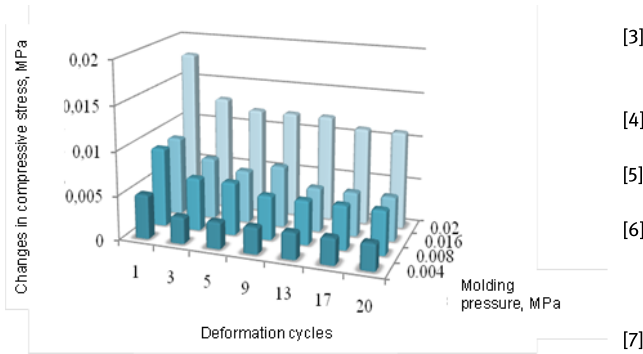
Figure 3: Changes in compressive stress at 10% deformation with number of deformation cycles of composite material and molding pressure. Polymer binder content 18